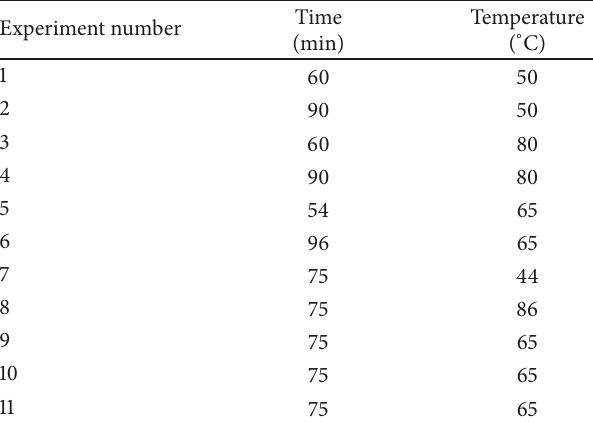
Table 1: Thermal extraction conditions for fresh and dried clado- desof O. cochenillifera